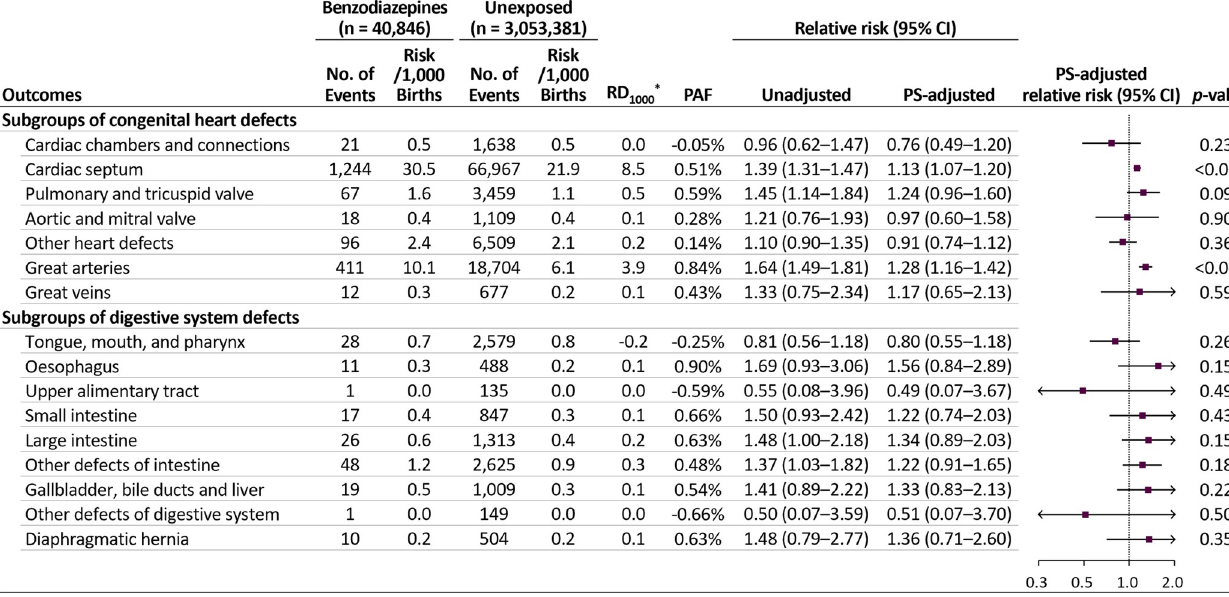
PLOS Medicine| https://doi.org/10.1371/journal.pmed.1003945 March 2,